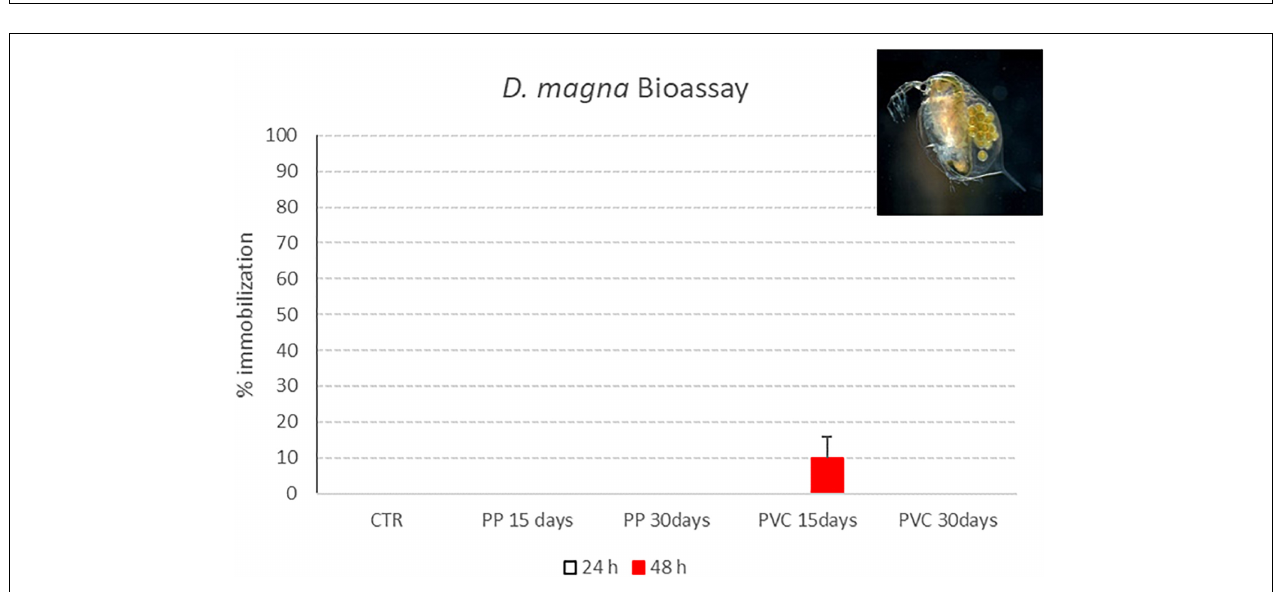
FIGURE 7 | Algal growth alteration percentage (vs. control) of P. subcapitata exposed for 72 h to PP 15 days, PP 30 days, PVC 15 days and PVC 30 days (samples after degradation with photocatalytic device) (M ± ES; n = 3).